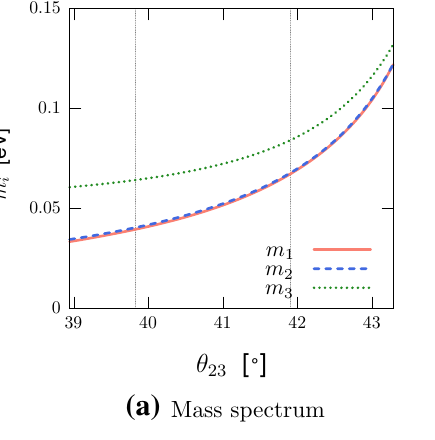
1 σ (2 σ ) errors in the parameters θ 12 , θ 13 , δ m 2 , and (cid:6) m 2 . The entire region is within the 2 σ range of θ 23 , while its 1 σ range is between the thin vertical dotted lines. We also show in the black dashed line the present limit imposed by the Planck experiment: (Planck TT+lowP+lensing+ext) [68]